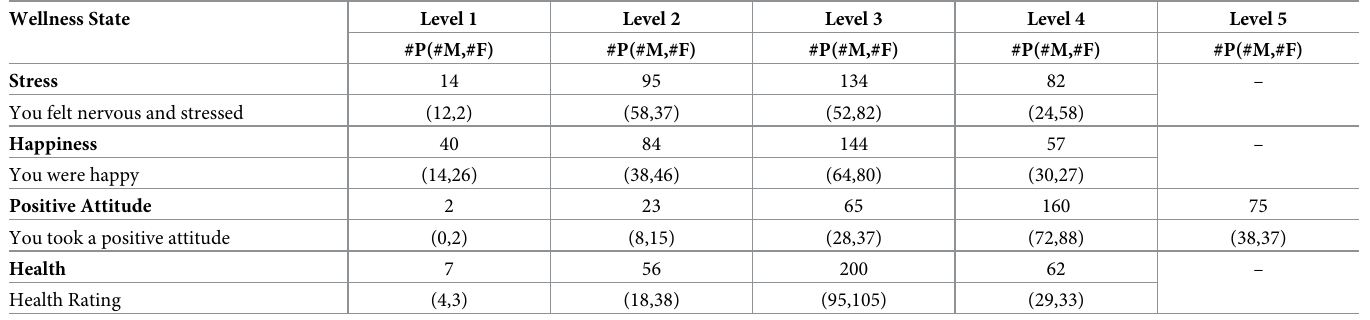
Table 2. Summary of wellness-related survey data in the NetHealth study.